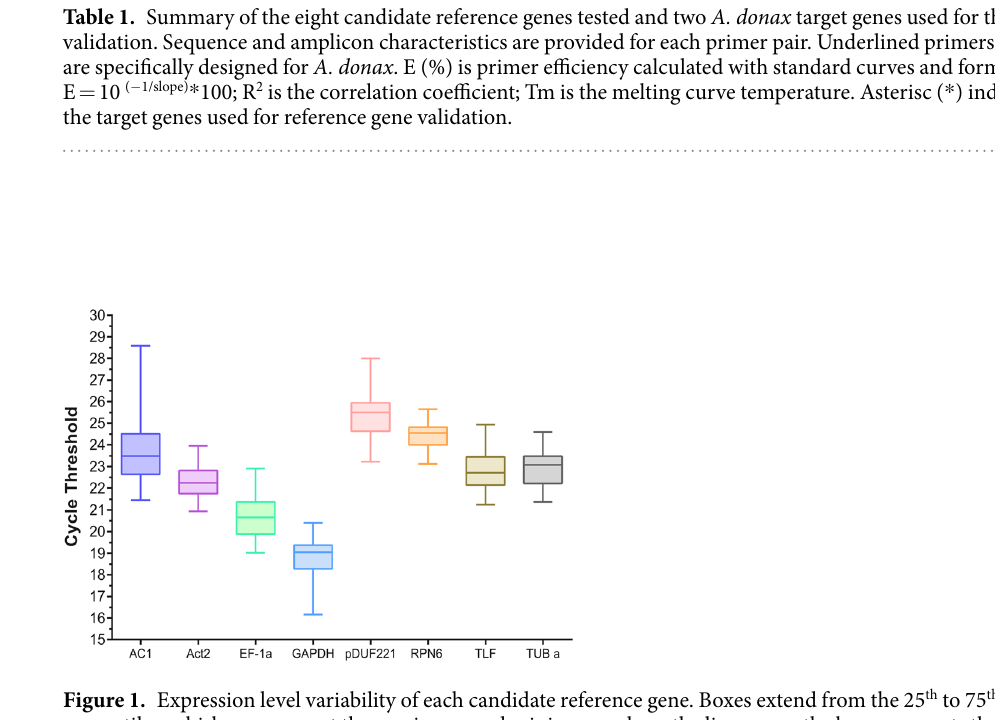
Figure 1. Expression level variability of each candidate reference gene. Boxes extend from the 25 th to 75 th percentiles, whiskers represent the maximum and minimum values, the line across the box represents the median value of the Cq values for each